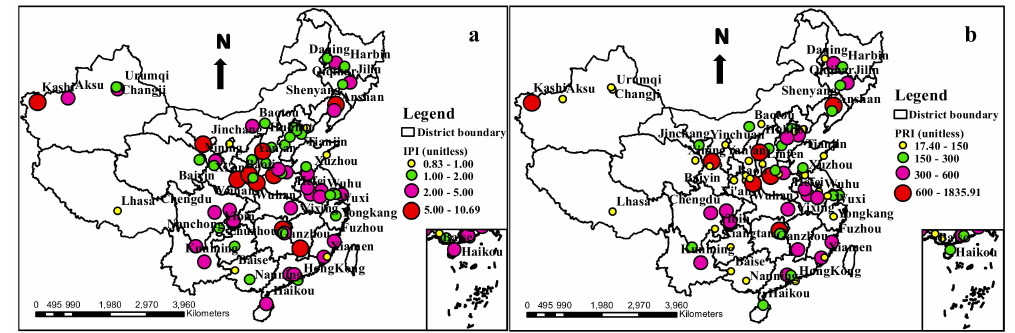
Figure 5. The distribution of integrated pollution index ( IPI ) and potential ecological risk index ( PRI ) of heavy metals in urban soils around China. ( a ): The distribution of IPI of heavy metals in urban soils around China. ( b ): The distribution of PRI of heavy metals in urban soils around